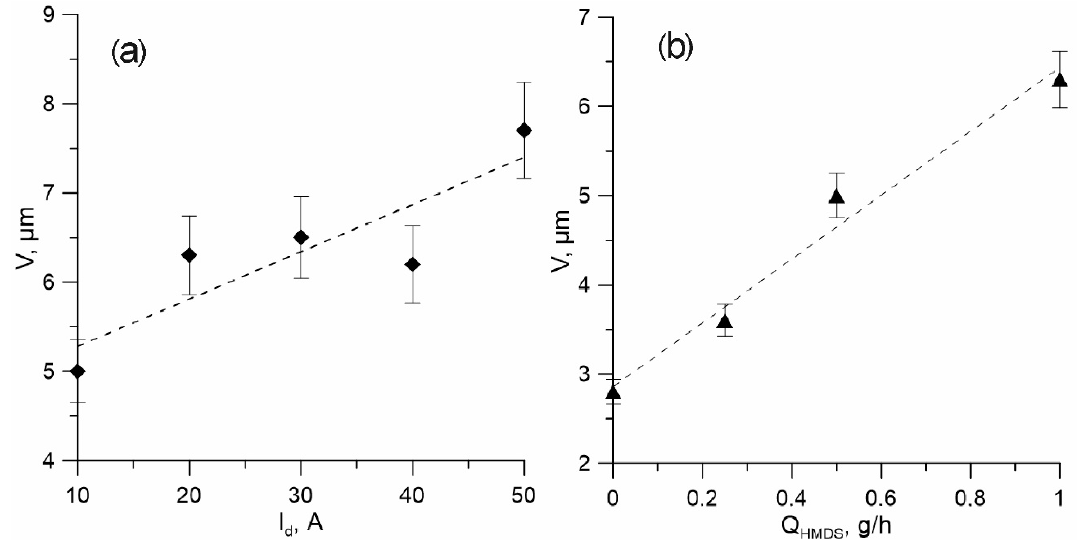
Figure 5. Dependences of the deposition rate of coatings on the discharge current I d ( a ) at Q HMDS = 1 g/h and on the flow Q HMDS ( b ) at I d = 20 A. I cr = 2 A, P tot = 0.45 mTorr.